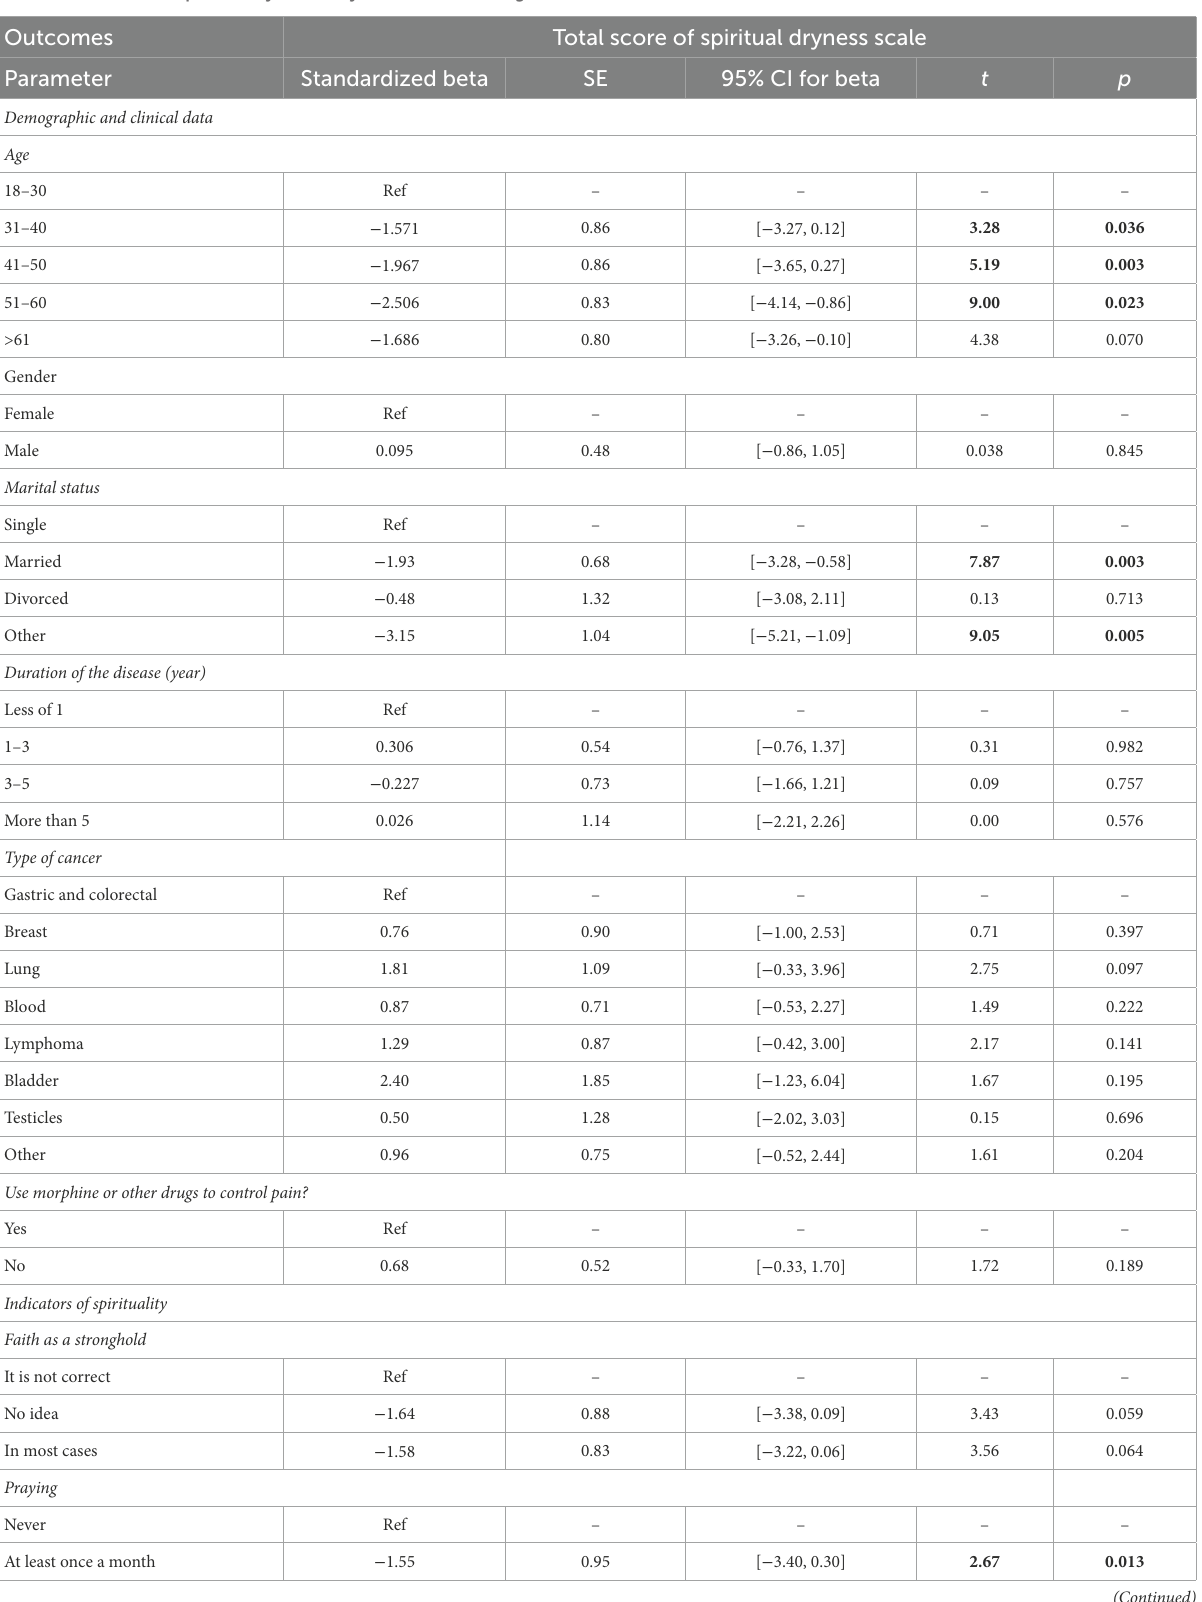
TABLE 4 Predictors of spiritual dryness analyzed in univariate regression. Outcomes